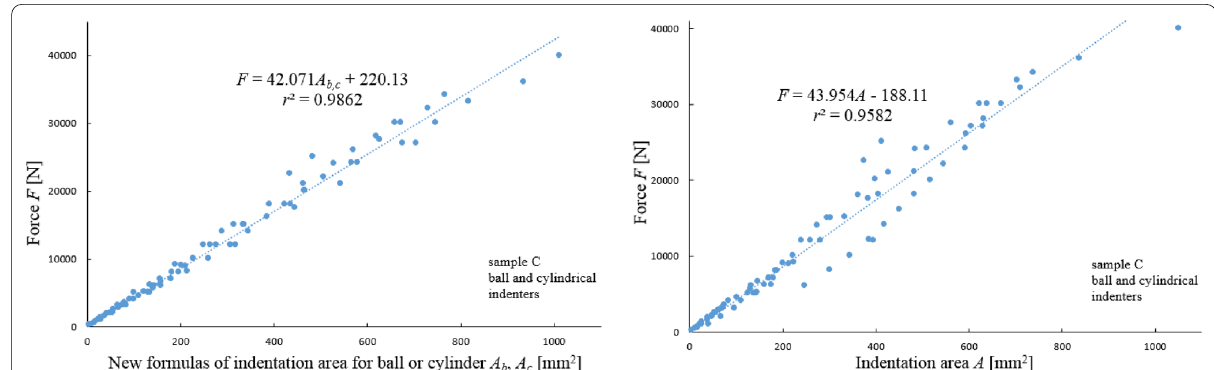
Fig. 11 Charts of the dependency of force F of indenter on the measure of the indentation area for all ball and cylindrical indenters for specimen C. Diagram on the left for new field measures A b and A c , and on the right for the total area of indentation A